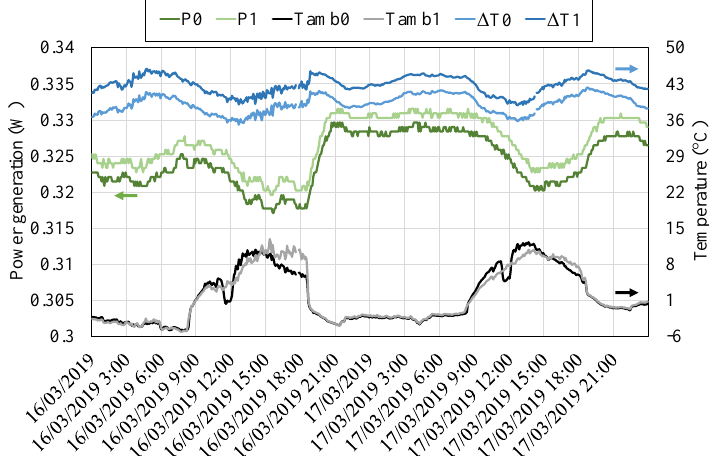
Figure 13. Power generated by the thermoelectric modules (left axis) and ambient temperature (right